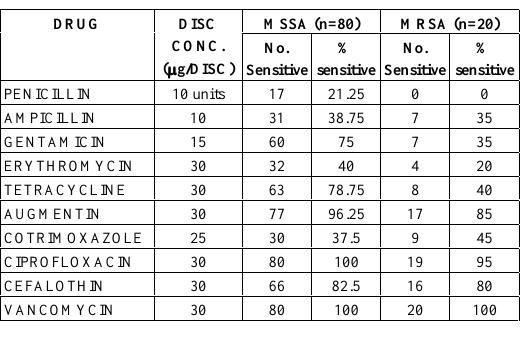
A COMPARISON OF ANTIBIOTIC SUSCEPTIBILITY PATTERNS OF MRSA STRAINS WITH MSSA